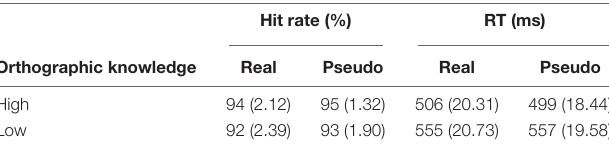
TABLE 2 | The P1 and N170 latency (ms) for real and pseudo TABLE 1 | Hit rate (%) and reaction time (ms) to targets in the color-matching task. Hit rate (%) RT (ms)